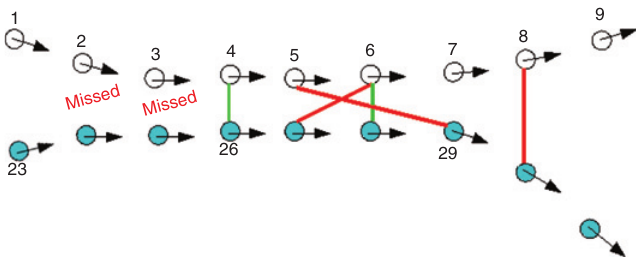
Figure 2. Illustration of Loop-Closure Detection Limitations for Topometric Mapping. A wrong matching is highlighted in red. It shows a system not reactive enough, not temporally consistent, and inaccurate in terms of robot position. In this particular case, we expected the loop-closure: 3–25, 4–26, 5–27, 6–28, and